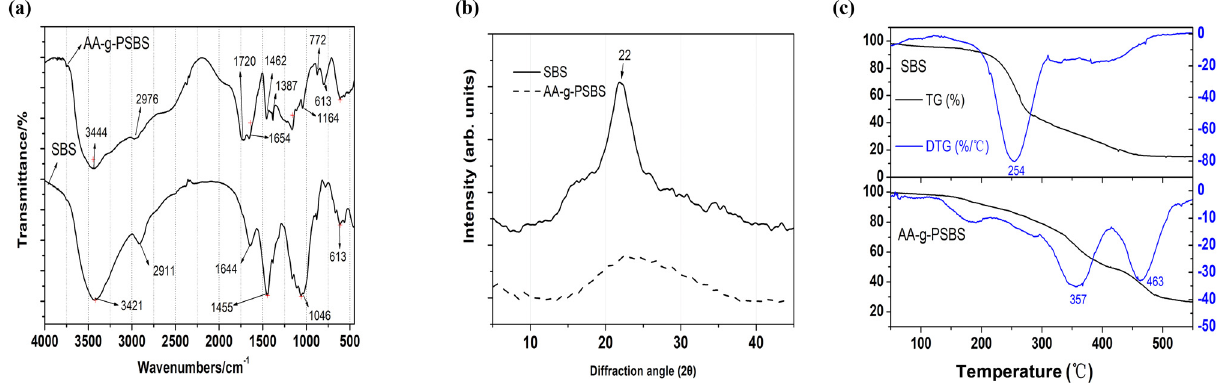
Figure 1: ( a ) Infrared spectra of AA - g - PSBS and SBS. ( b ) XRD of AA - g - PSBS and SBS. ( c ) TGA of AA - g - PSBSand